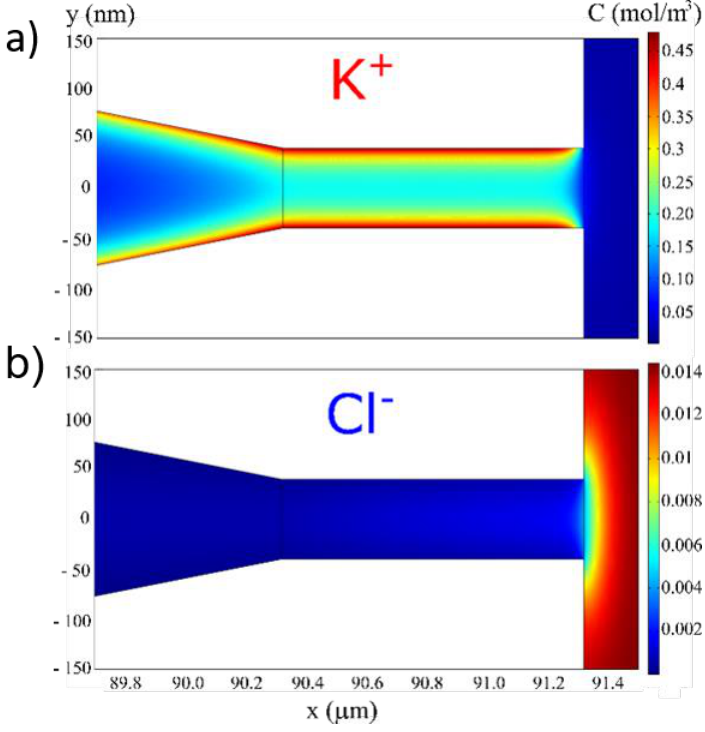
Figure 7. K + ( a ) and Cl − ( b ) concentrations in the nanochannel at C Bulk 10 −5 M (10 −2 mol/m 3 ), with +1 V applied between the reservoirs.